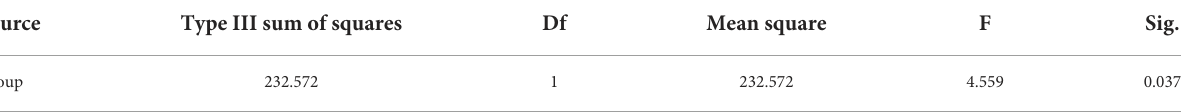
TABLE 7 Tests of between-subjects effects for flow scores. Source